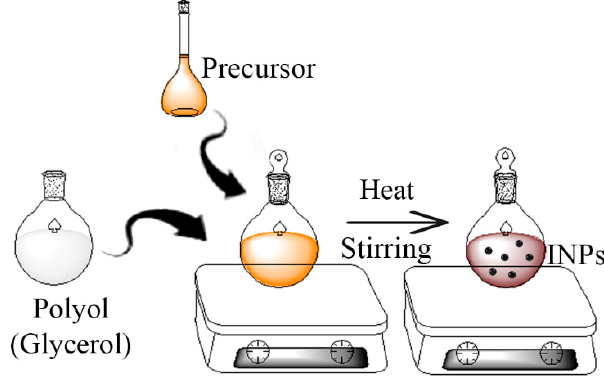
Scheme 2. Schematic illustration of a polyol reaction.